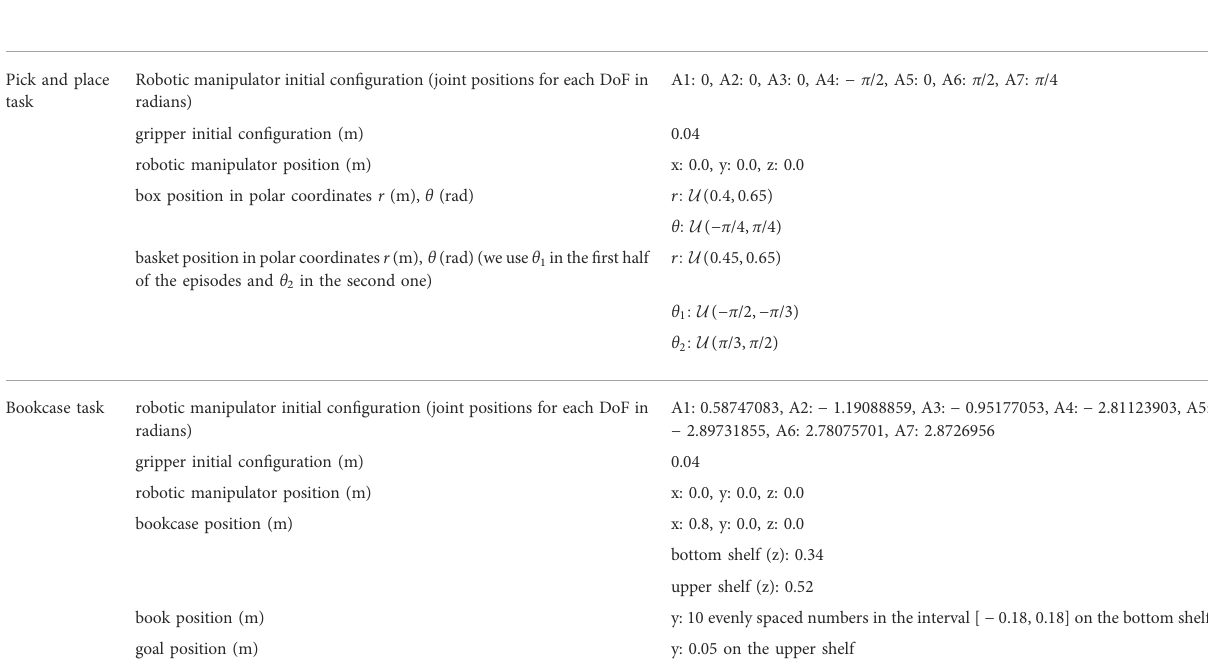
TABLE 1 Environmental setup used during data